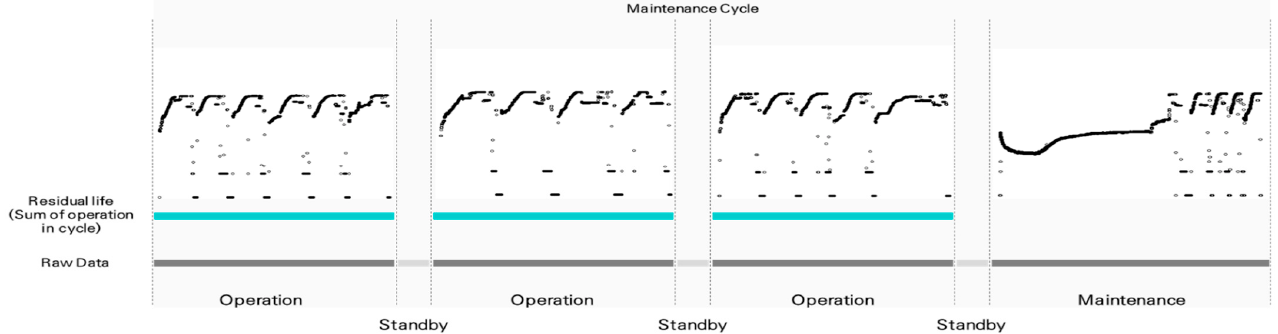
Figure 3. Process diagram of the maintenance cycle.